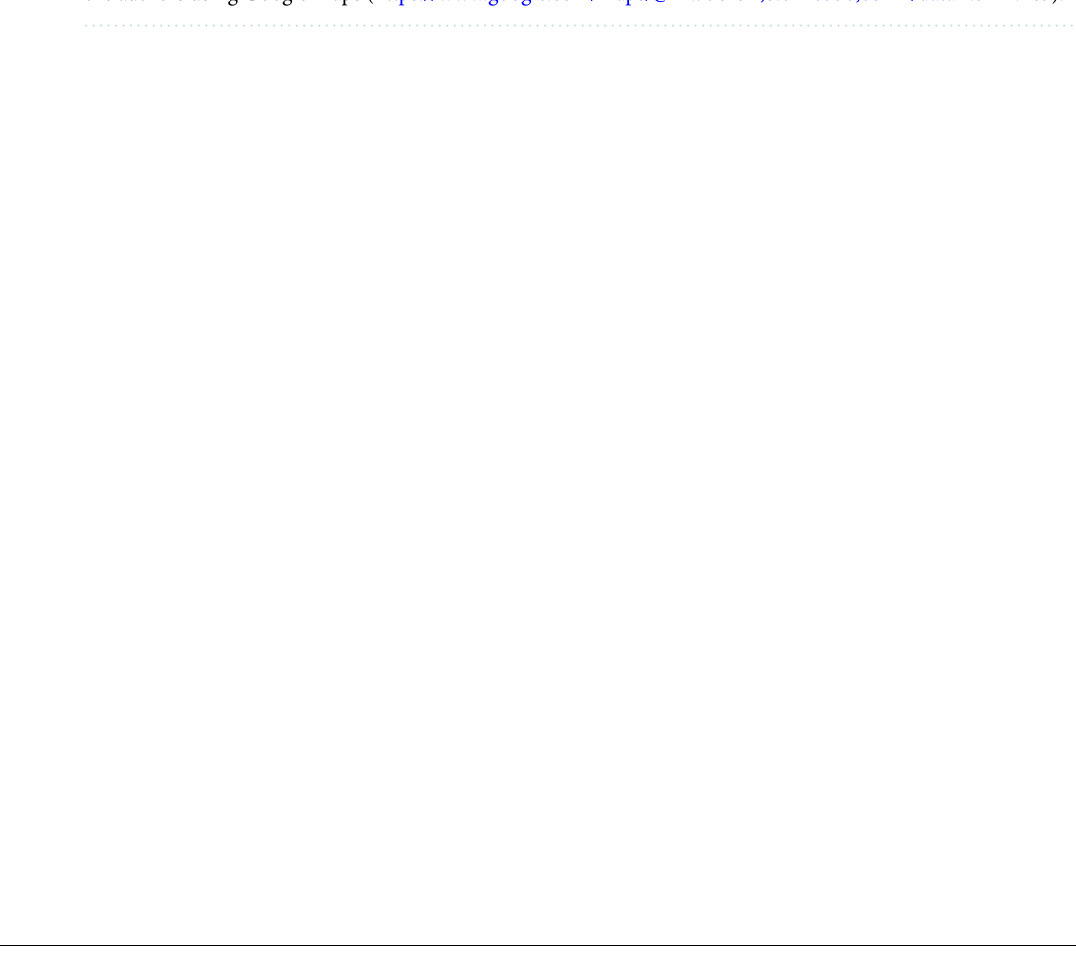
Figure 1. Grapevine at the two sampling times corresponding to two phenological stages: ( A ) flowering and ( B ) early fruit development. ( C ) Map of the sampling site: bulk soil and rhizosphere are indicated in the map; the red tag indicates the coordinates specified in the materials and methods. The map image was produced by the authors using Google Maps (https:// www. google. com/ maps/@ 44. 73029 4,8. 62265 56,681m/ data=